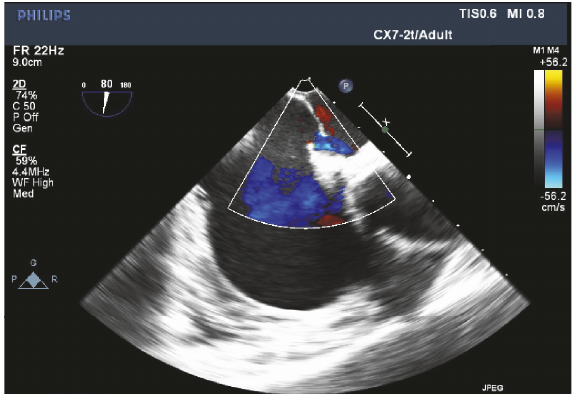
Figure 3: TEE mid-esophageal RV inflow-outflow view with color flow Doppler showing atria septum consistent with PFO (predominant R-to-L